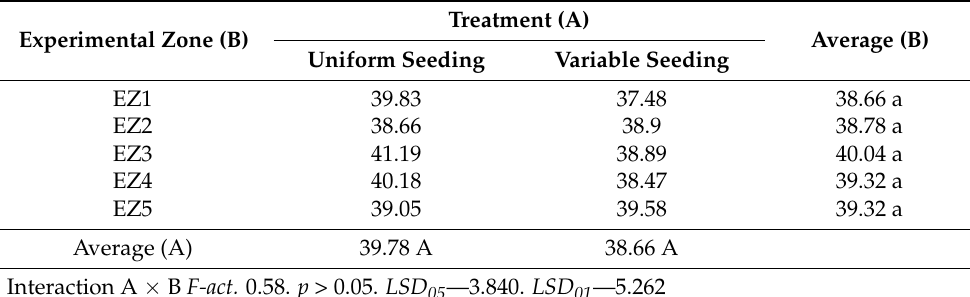
Table 9. The 1000-grain mass values of winter wheat for different zones and seeding treatments of experiment